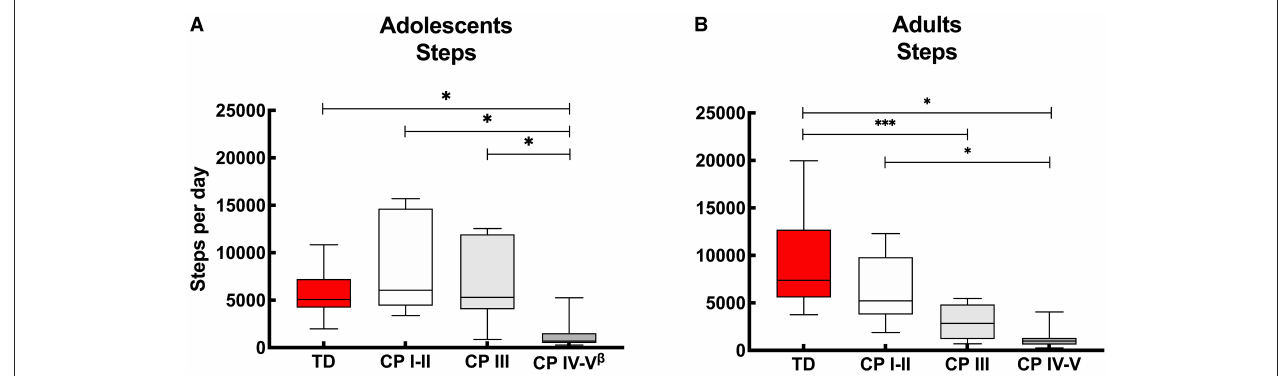
FIGURE 1 | Box and whisker plots for daily step count of (A) adolescents and (B) adults with cerebral palsy (CP) and typically developing (TD) peers. CP groups include CP I-II, participants with CP classified in Gross Motor Functional Classification System (GMFCS) level I and II; CP III, participants with CP classified in GMFCS level III; CP IV-V, participants with CP classified in GMFCS level IV and V. ß Data of 2 adolescents excluded: n = 24. *Significant difference found for “whole week,” “weekdays” and “weekend days;” ***significant difference found for “whole week” and “weekdays” ( p <